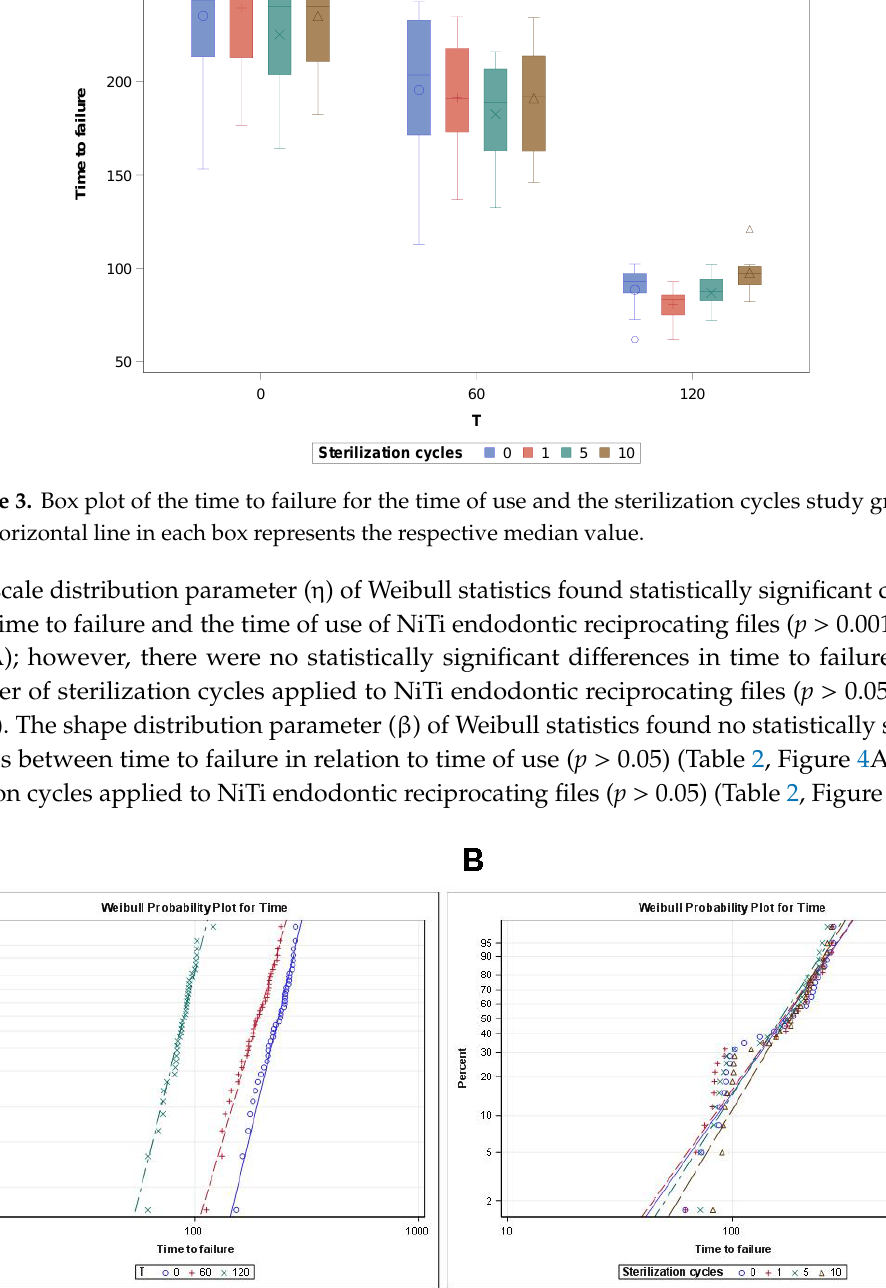
Table 2. Weibull statistics of time to failure for the time of use and the sterilization cycles study groups.